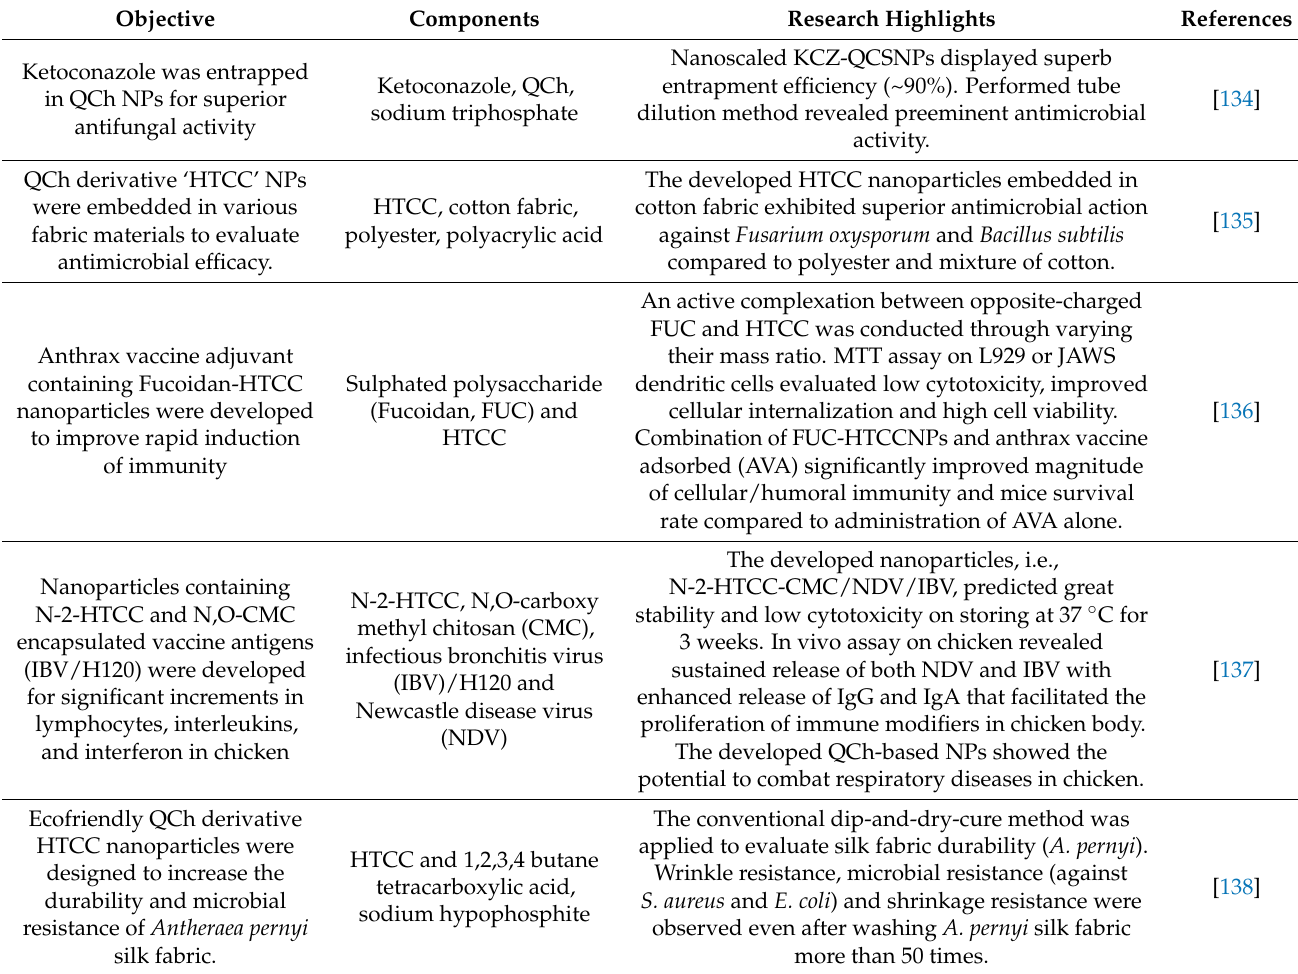
Table 5. QCh-based nanoparticles and their biomedical